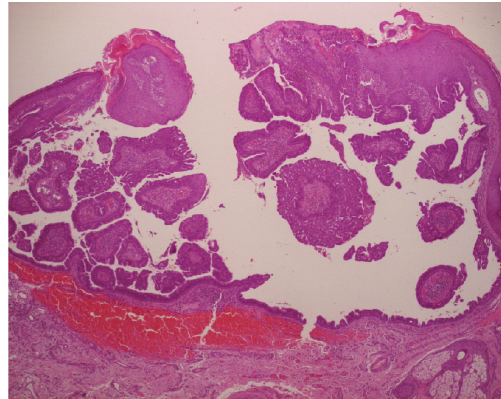
Figure 3: Hematoxylin-eosin stain (4x) showed a dermal nodule with many glandular structures and papillary folds.